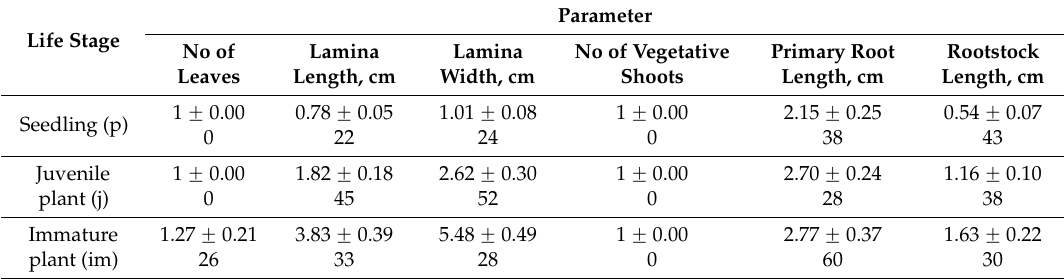
Table 1. Morphological characteristics of young individuals (p, j, im) of Anemone patens ( n = 10 for each life stage) . In the numerator is the mean ( X ̅ ) and its standard error (± SE ), and in the denominator the coefficient of variation ( % С V ).